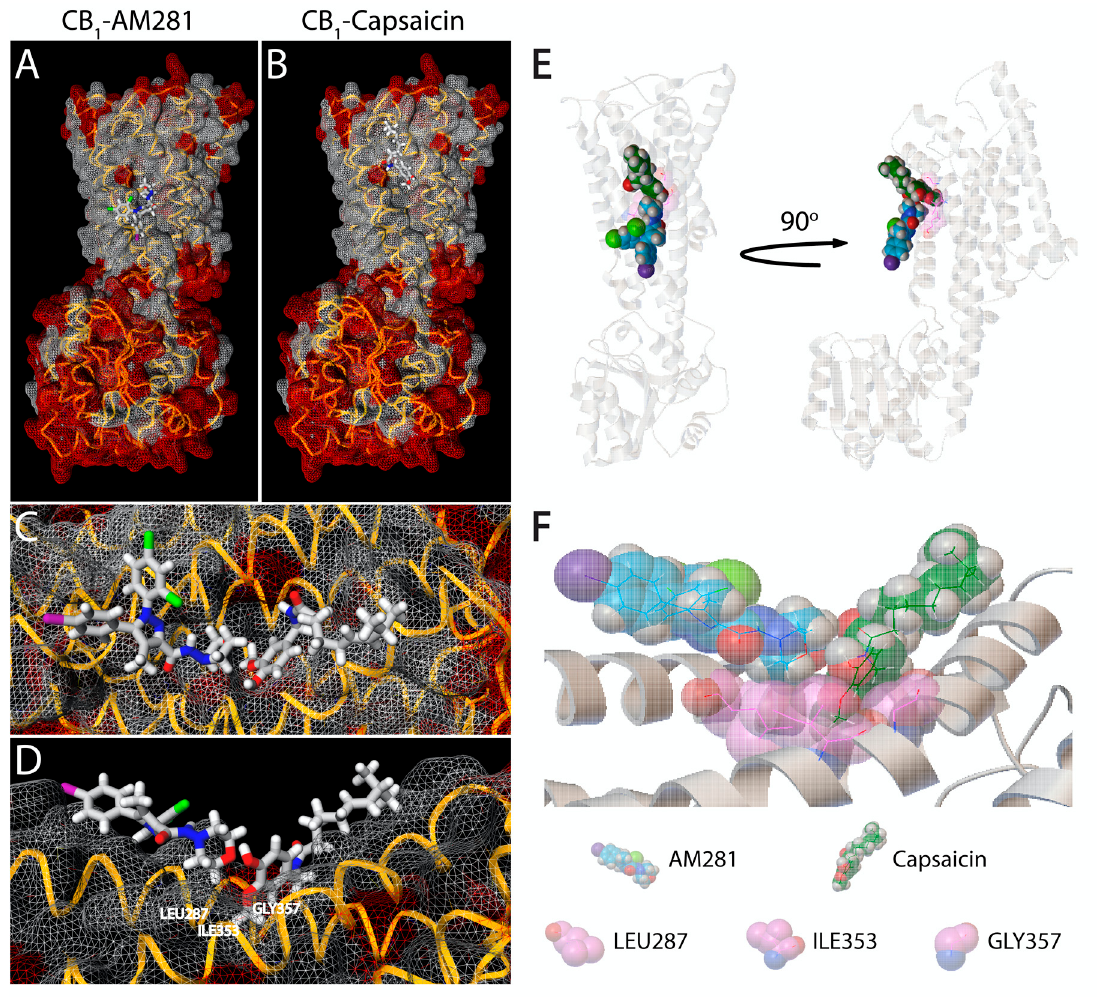
Figure 5. AM281 and Capsaicin binds to human CB 1 receptor at the same binding region. ( A , B ) CB 1 docking simulation presenting the predicted binding of AM281 and Capsaicin, respectively. ( C ) Front view and ( D ) Side view of CB 1 -AM281 and CB 1 -Capsaicin binding regions. ( E ) Superimposition of the two ligands models showing CB 1 receptor displaying ribbon structure and the ligand molecules displaying atomic spheres (AM281 in blue and Capsaicin in green), as well as the cavity formed by the relevant residues in pink. ( F ) Close up of the two-model superimposition showing that the methoxy moiety of Capsaicin is internalized in the cavity formed by LEU287, ILE353 and GLY357.